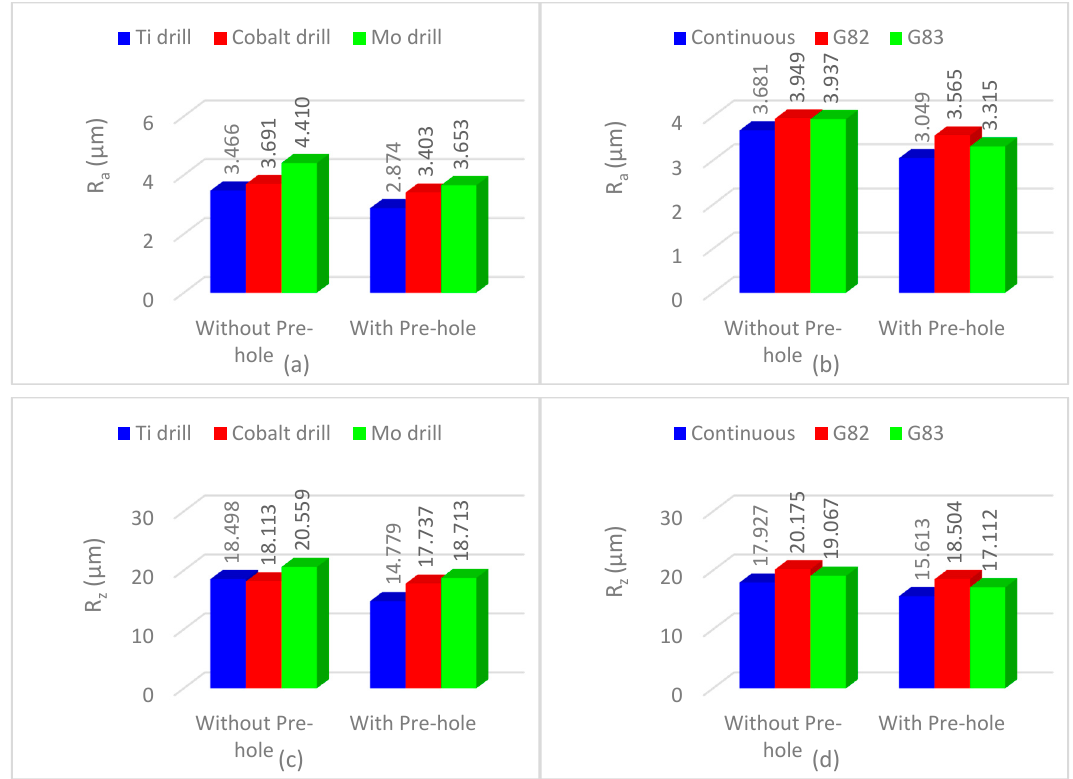
Figure 6. The effect of using different cutters and strategies on ( a , b ) average roughness and ( c , d ) mean roughness depth.